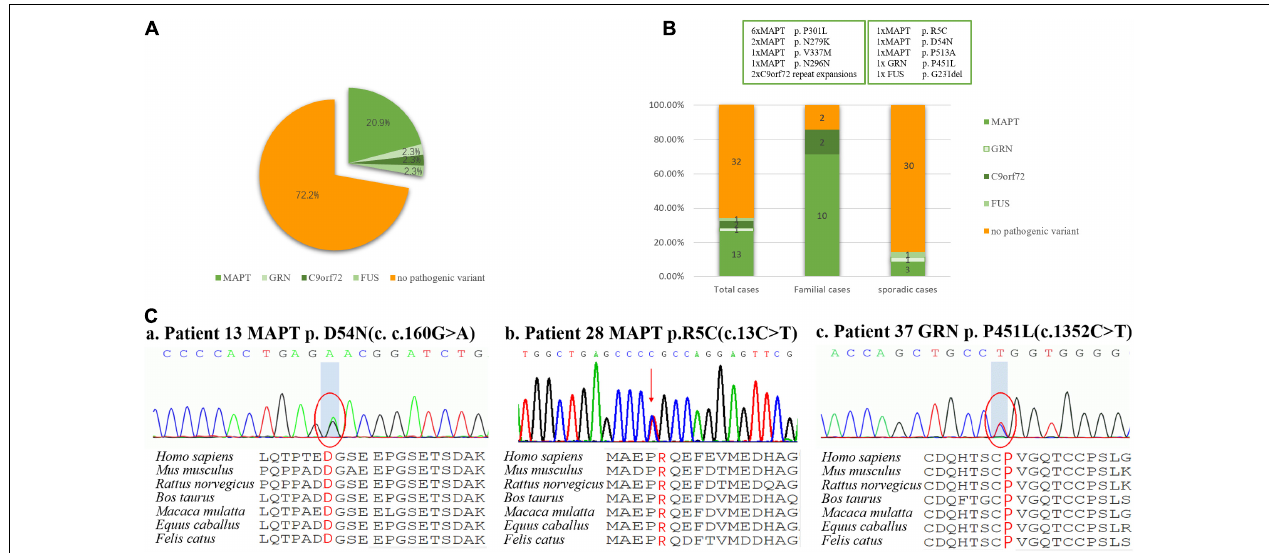
FIGURE 1 | Frequency of mutations in a consecutive series of 49 subjects with behavioral variant frontotemporal dementia. (A) 27.9% of subjects carried mutations, including those of MAPT, GRN, FUS, and C9orf72 repeat expansion, but surprisingly not CHCHD10. (B) Mutations were found in 87.5% of familial subjects and 14.3% of sporadic subjects. (C) Sanger sequencing revealed two novel missense mutations of MAPT (p. R5C and p. D54N), and one novel missense mutation of GRN (p. P451L). These missense mutations were present at a highly conserved position, as indicated by a comparison of the corresponding sequences of seven vertebrate